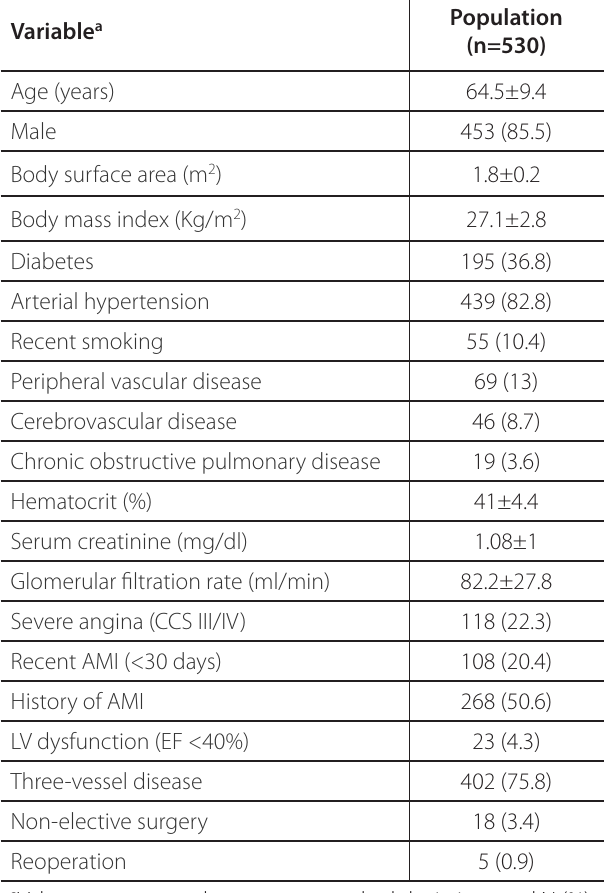
Table 1 . Patients’ demographic and clinical characteristics.